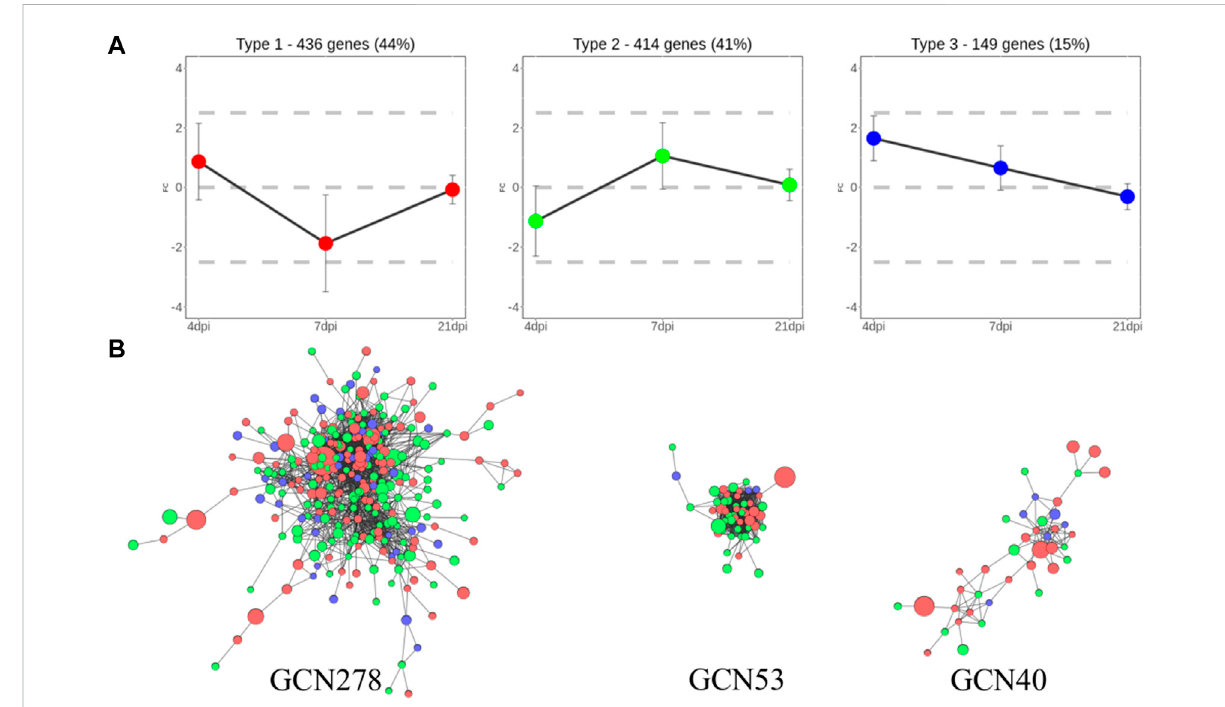
FIGURE 3 Clustered DEGs using two different grouping methods (A) Three types of clusters separated based on their gene expression patterns. In total, 436, 414, and 149 genes were assigned to Types 1, 2, and 3, respectively. (B) GCNs clustered using gene co-expression values. Each node is a gene colored with its expression type. Node size re fl ects absolute log 2 FC. Edges between nodes represent signi fi cant co-expression of genes. Network names re fl ect the number of genes they